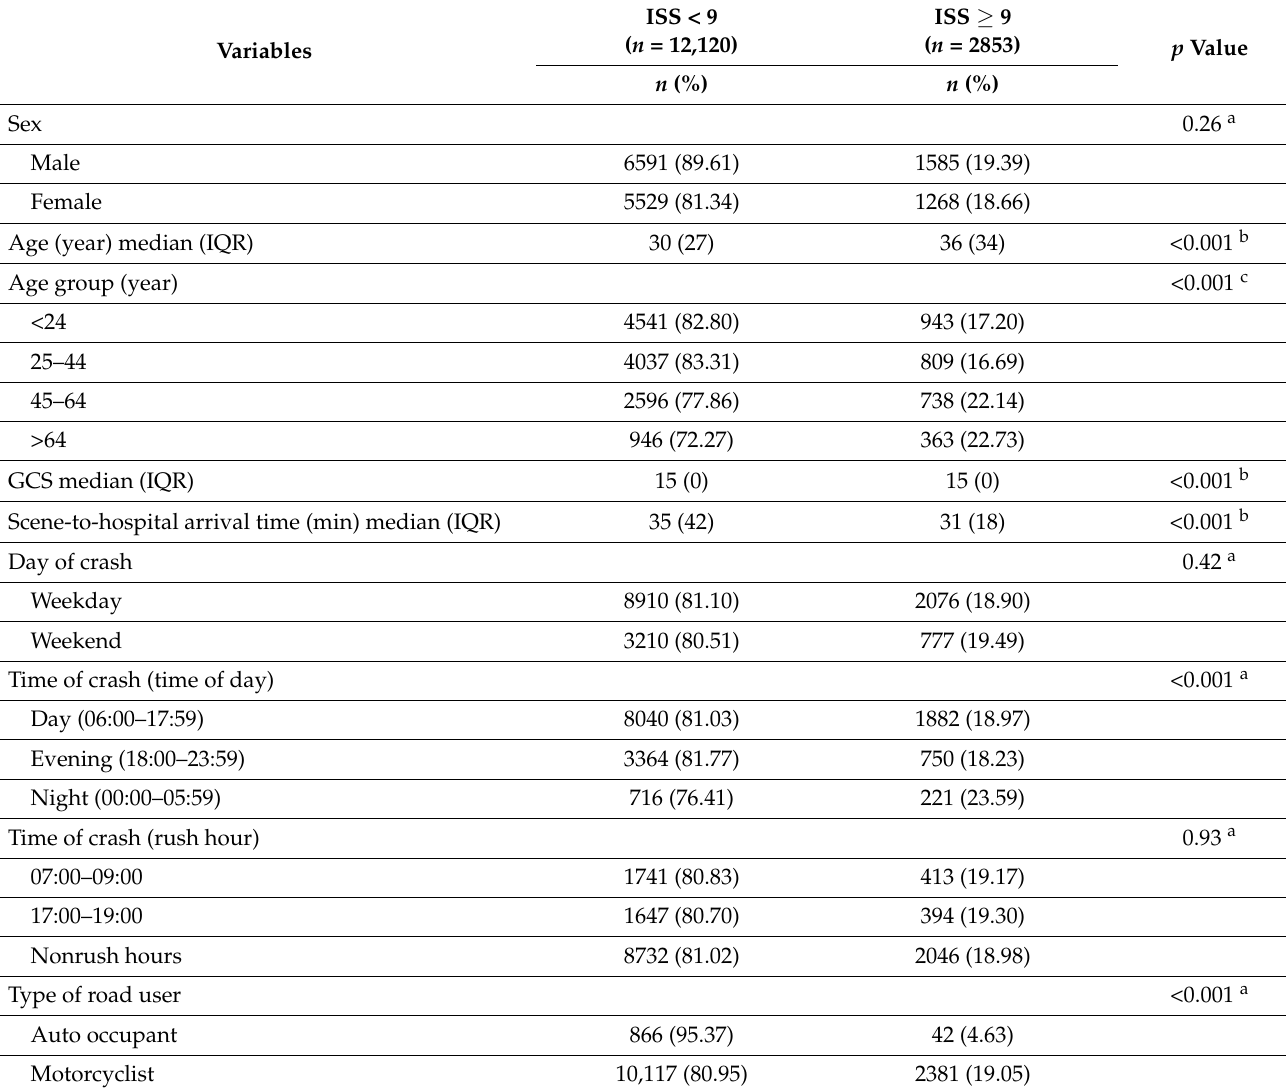
Table 1. Summary of independent variables for patients with ISSs of <9 and ≥